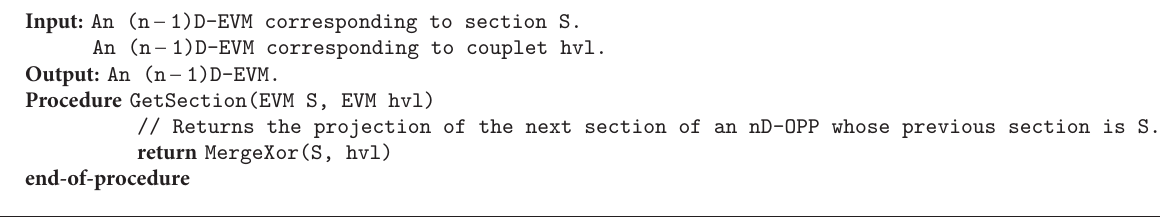
Algorithm 2: Computing sections from couplets.